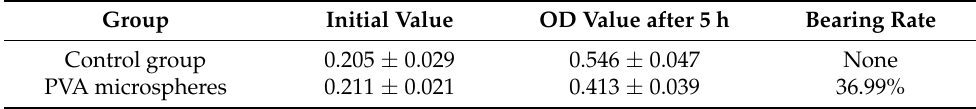
Table 1. Ability of carrier microspheres for Bacillus velezensis .